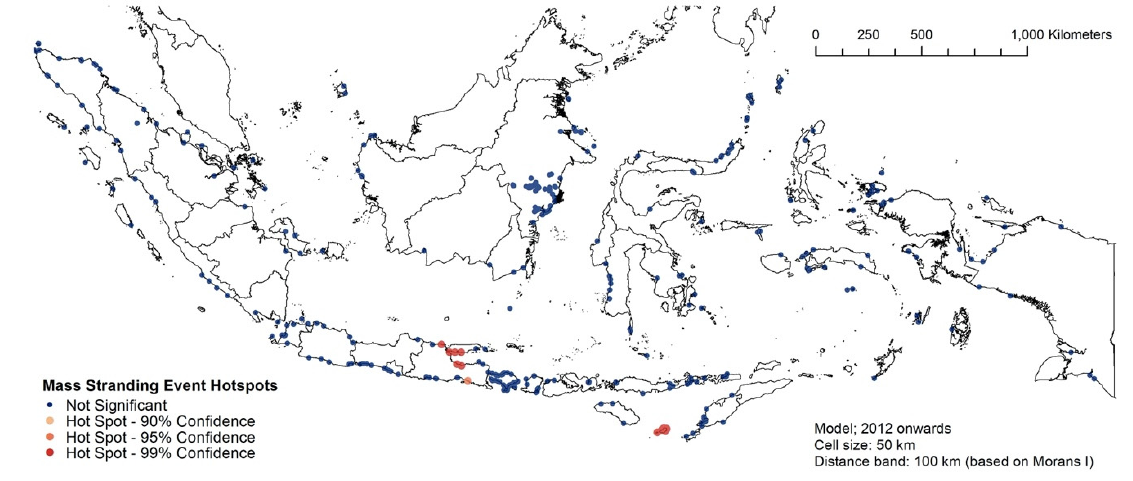
Figure 10. The spatial hotspot analysis of mass stranding events of 2012–2021.